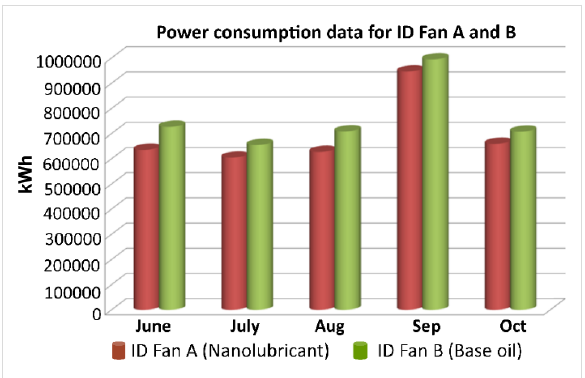
Figure 10: Power Consumption data for ID Fan A and B for few